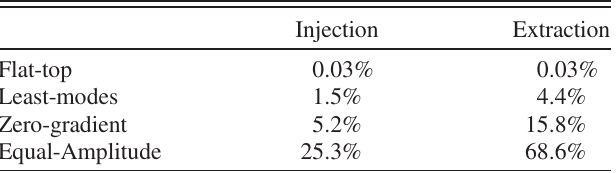
TABLE III. Emittance growth for different kicking waveform schemes.